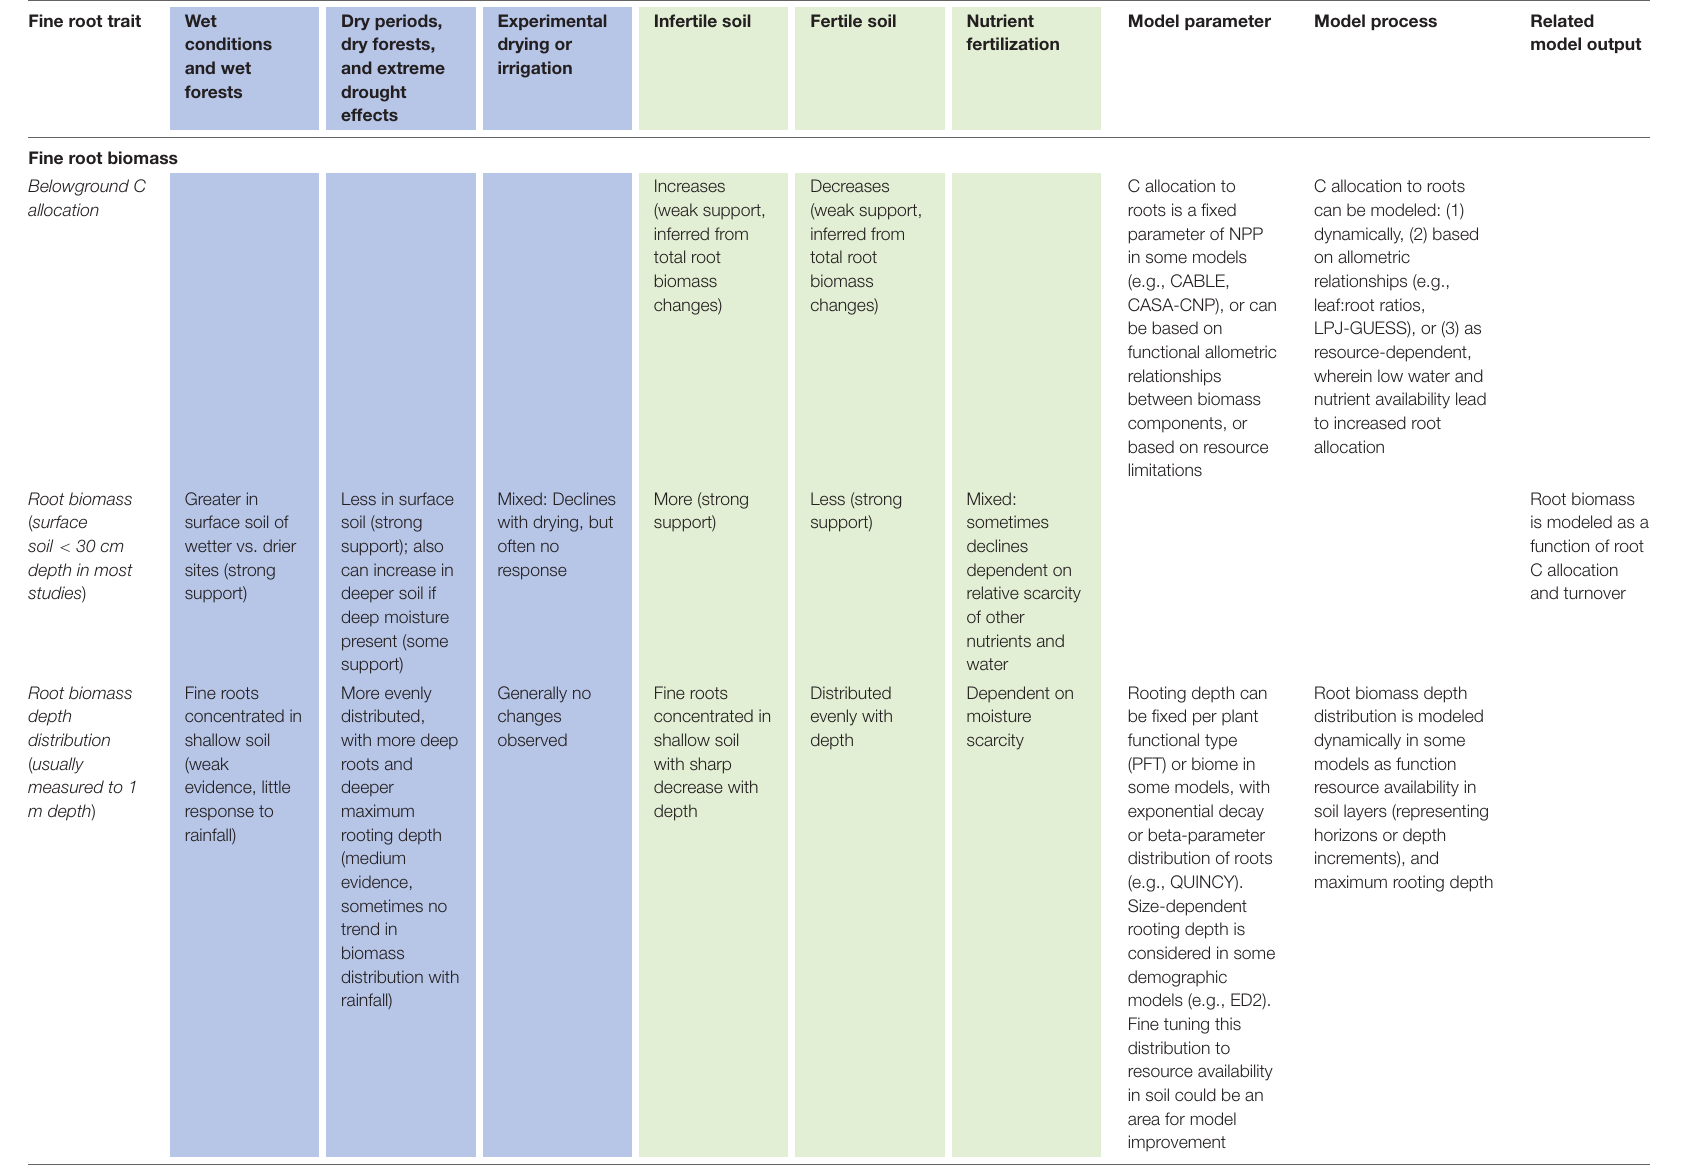
TABLE 1 | Summary of how the different root traits respond to resource variation (blue = water, green = nutrients) based on empirical studies in tropical forests (cited in the text), and summary of the roles of different root traits in vegetation and nutrient uptake models. Fine root